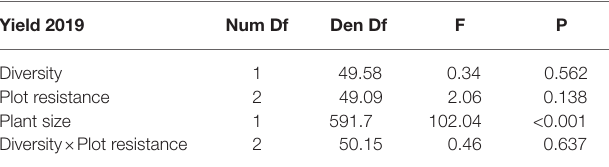
TABLE 4 | Results of a generalized linear mixed model testing the effects of plot diversity ( high and low , with 10 and two varieties, respectively), plot resistance ( resistant , susceptible and 50:50 mixture of the two ), and average plant size (height × width, cm 2 ) measured at the end of the growing season in 2018 on yield (fruit weight, g) of woodland strawberry ( Fragaria vesca ) in 2019.